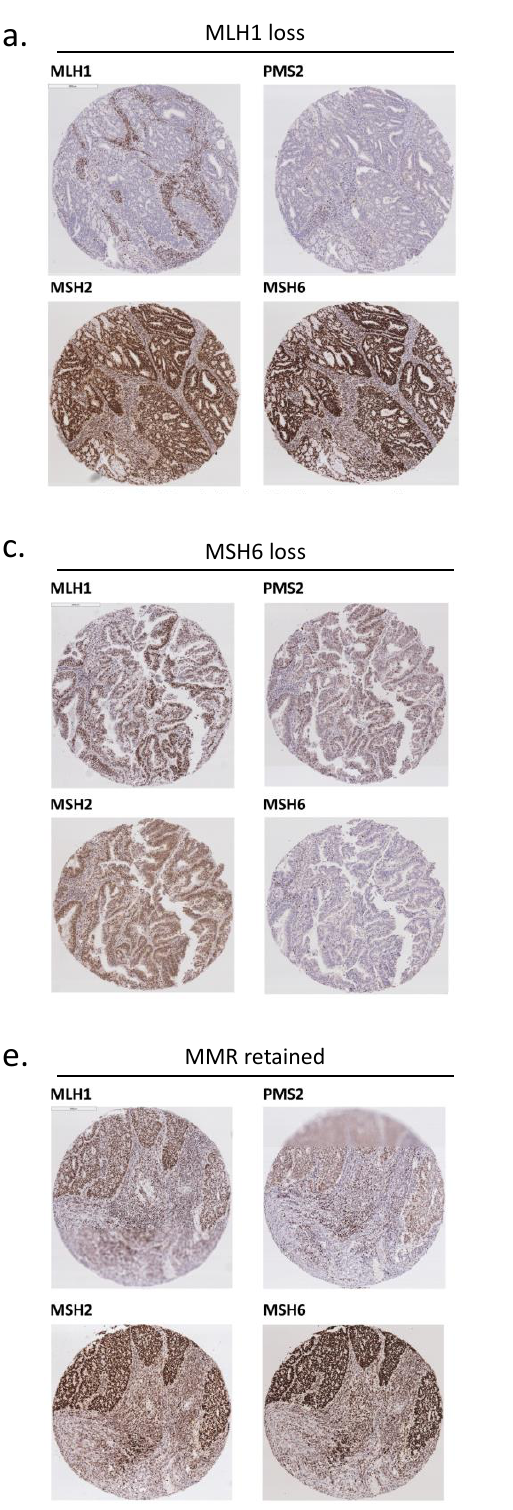
Figure 1. Expression of mismatch repair (MMR) proteins in endometrioid endometrial cancer tissues. ( a ) A representative case of MLH1 loss, immunohistochemistry (IHC) staining showed loss of MLH1 protein expression in tumor cells. ( b ) A representative case of MSH2 loss, IHC staining showed loss of MSH2 protein expression in tumor cells. ( c ) A representative case of MSH6 loss, IHC staining showed loss of MSH6 protein expression in tumor cells. ( d ) A representative case of PMS2 loss, IHC staining showed loss of PMS2 protein expression in tumor cells. ( e ) A representative case of MMR retained, IHC staining showed all four of the MMR proteins (MLH1, MSH2, MSH6 and PMS2) retained in tumor cells.